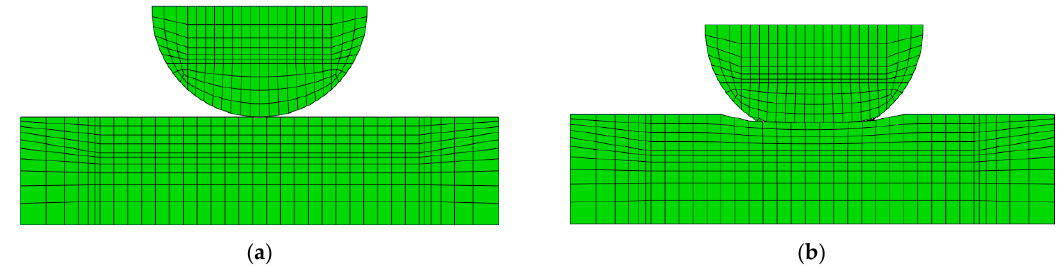
Figure 10. Detail of the contact zone (section on the axis of the applied displacement) for ( a ) fretting cycles of 100, where it is observed that the wear is negligible in the contact zone and ( b ) fretting cycles of 100,000, where it is observed that the wear is appreciable in the contact zone.